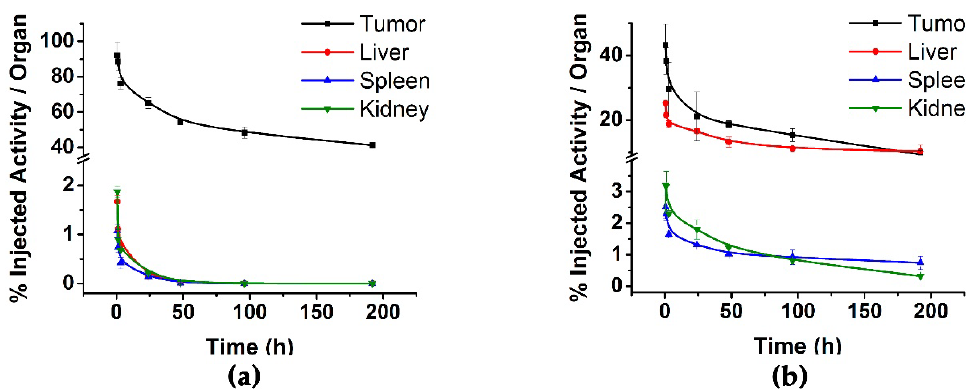
Figure 5. Comparison of the biokinetic profile between the ( a ) 225 Ac-rHDL nanosystem and ( b ) 225 Ac-DOTA-benzene-p-SCN in nude mice bearing HEP-G2 tumors after intratumoral administration.